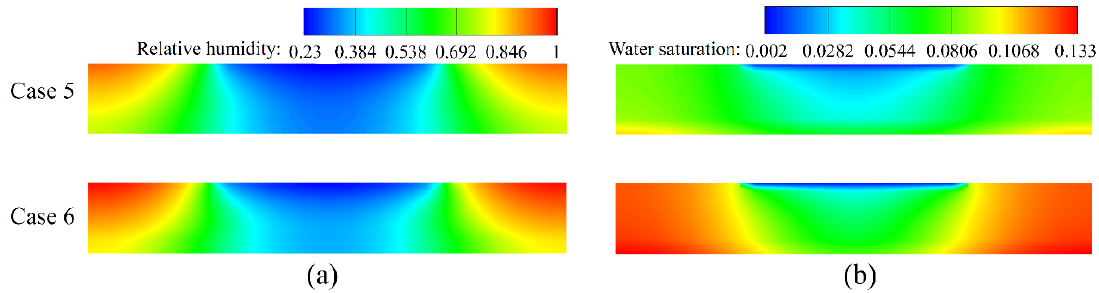
Figure 7. Comparison of ( a ) relative humidity and ( b ) liquid water saturation distribution in the through-plane cross section of cathode membrane assembly.